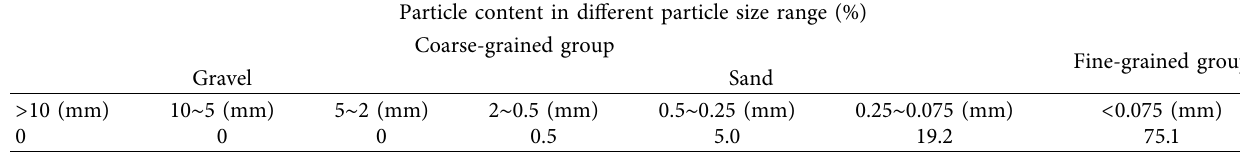
Table 4: The grain size distribution of the test soil.